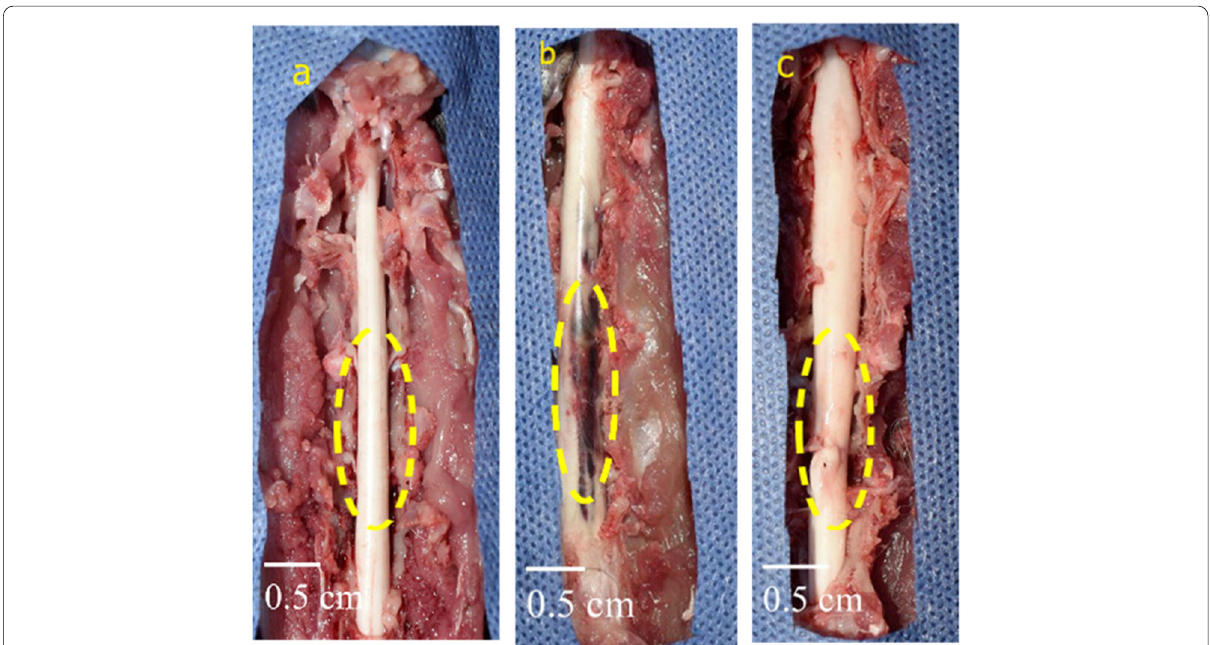
Fig. 2 The gross morphology of the spinal cord at the end of the experiment at day 42. A Control negative group. B EB-treated group. C PRP co-treated group